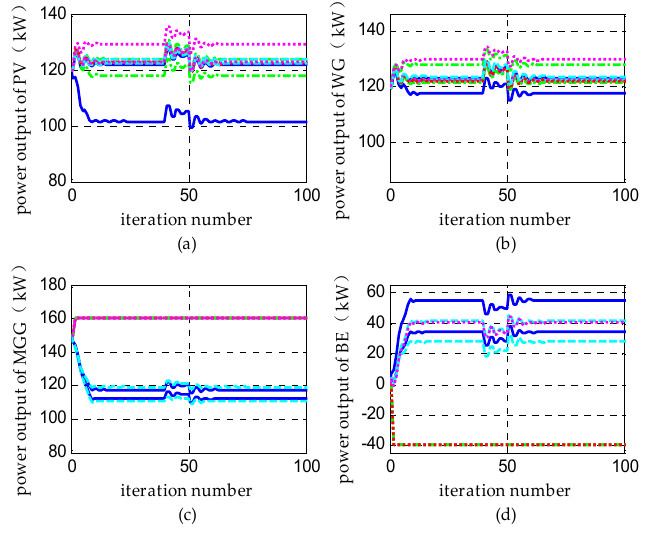
Figure 12. Dispatch results in Scenario E . ( a ) Power output of PV; ( b ) Power output of WG; ( c ) Power output of MGG; and ( d ) Power output of BE.